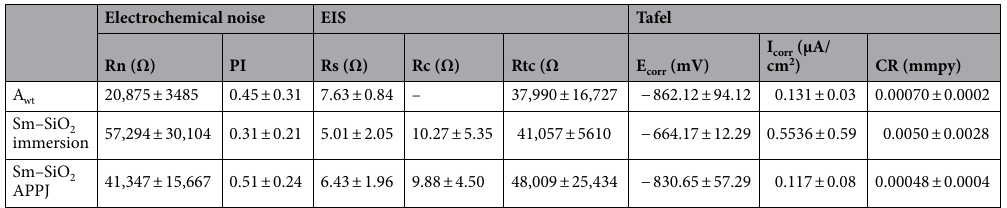
Table 2. Electrochemical analyses showing the electrochemical noise, EIS, and Tafel results.